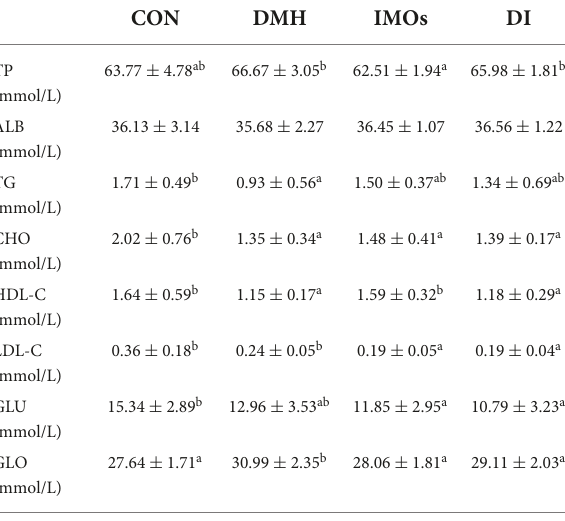
TABLE 1 Clinical chemistry data from serum samples after 12 weeks of